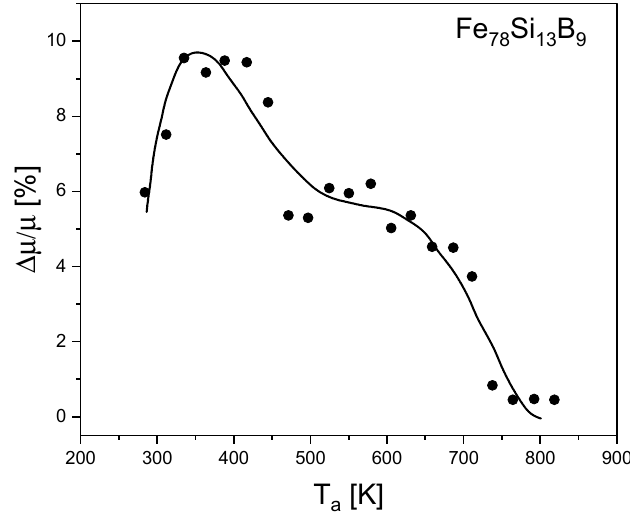
Figure 6. Magnetic aftereffects curves versus the 1 h annealing temperature. Figure 7 presents the primary magnetization curves B ( H , t ) obtained by static mea- surements, extrapolating to times t → 0 and t → ∞ . After integration in the H = f ( B ) coordinate system, the value E st = 0.018 J/m 3 was obtained.